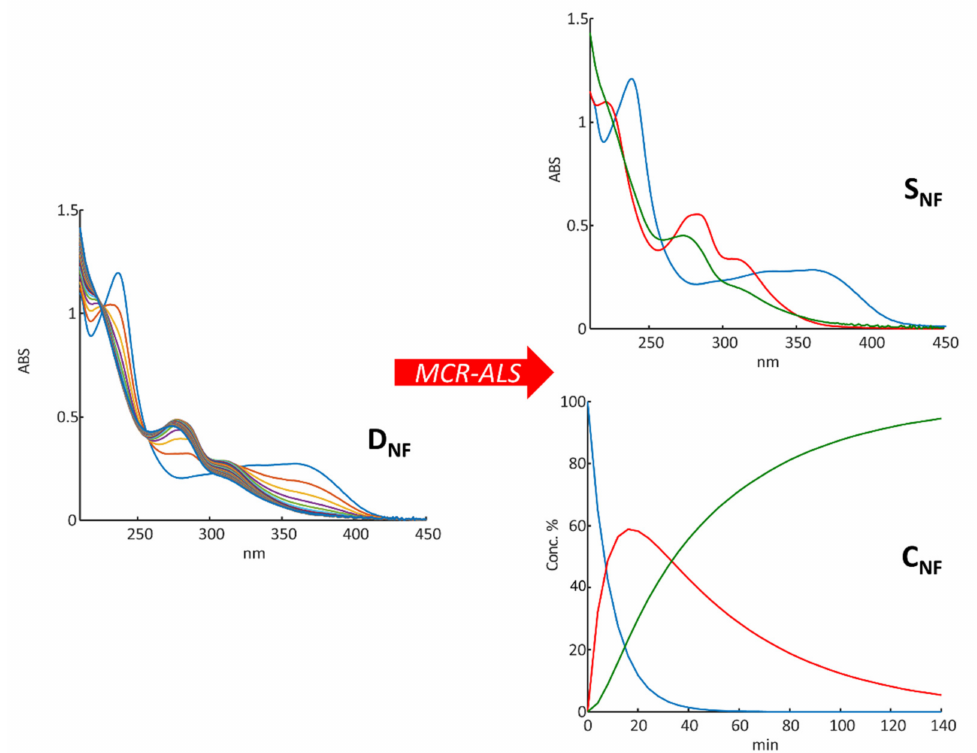
Figure 1. Sequence of the UV spectra of NF solution (20.0 µ g/mL) along the forced irradiation ( D NF ); and spectra ( S NF ) of the species involved in the photodegradation process predicted by MCR processing and their concentration profiles ( C NF